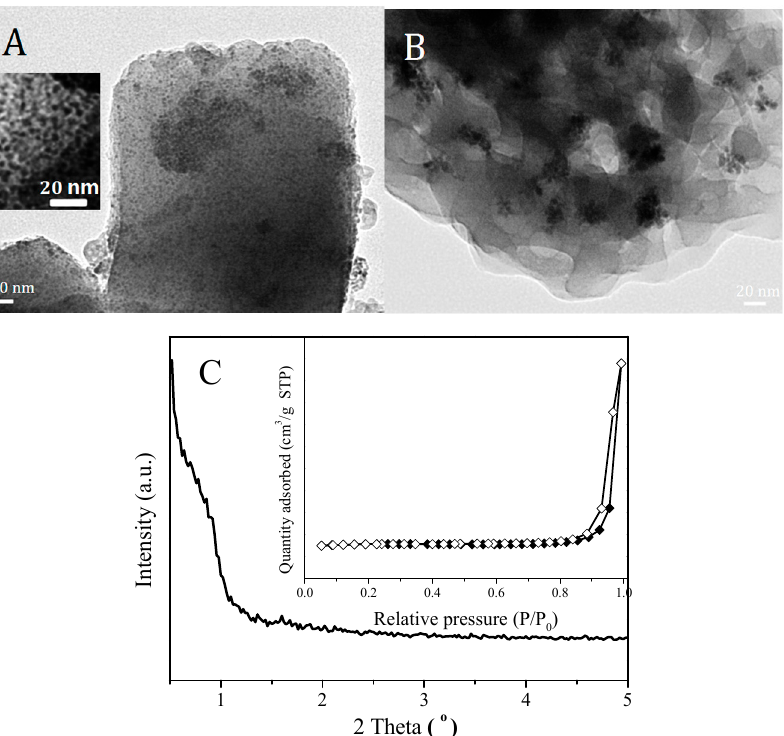
Figure 9. TEM images of ( A ) Pd ‐ diimine@SBA ‐ 15 and ( B ) Pd/SBA ‐ 15 repeatedly used four times; ( C ) SA ‐ XRD pattern and N 2 sorption isotherm of Pd ‐ diimine@SBA ‐ 15 repeatedly used four times.